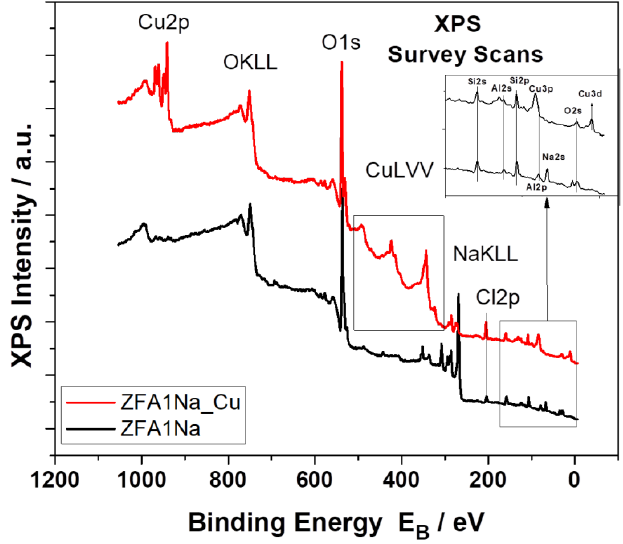
Figure 10. XPS survey scans of ZFA1Na and ZFA1Na_Cu samples. Table 5. Surface atomic concentrations of main elements in zeolite before (ZFA1Na) and after copper removal (ZFA1Na_Cu). Comparison of surface atomic ratios derived from XPS with SEM / EDS. Sample